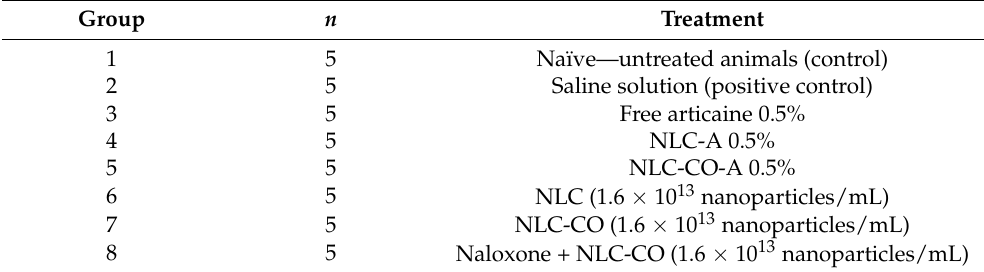
Table 6. Groups, number of animals ( n ), and treatments used in the hyperalgesia tests. Group